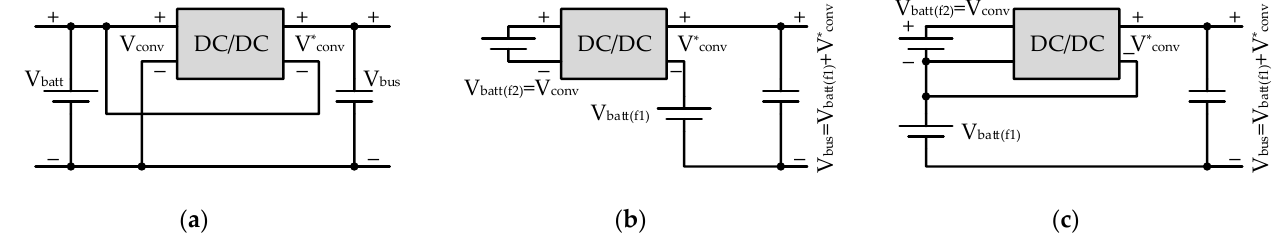
Figure 23. Partial power converters ( a ) vs. fractional power converters: ( b ) isolated, ( c ) non-isolated.